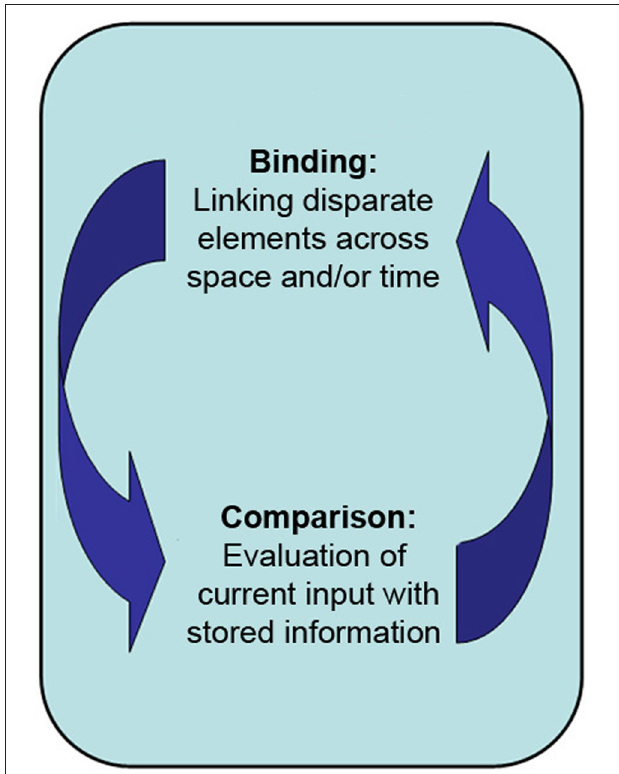
FIGURE 1 | The primary proposed role of the hippocampus is in the binding of disparate elements across both space and time into a lasting representation, and in the comparison of said representations with one another and/or with current perceptual